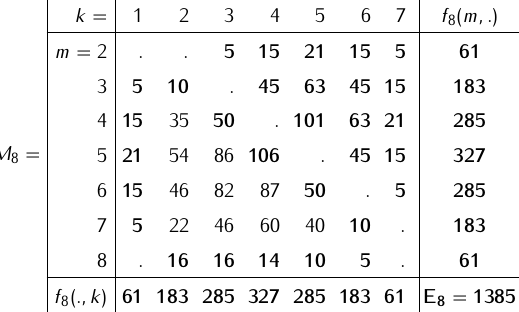
, bold-faced entries analytically 8